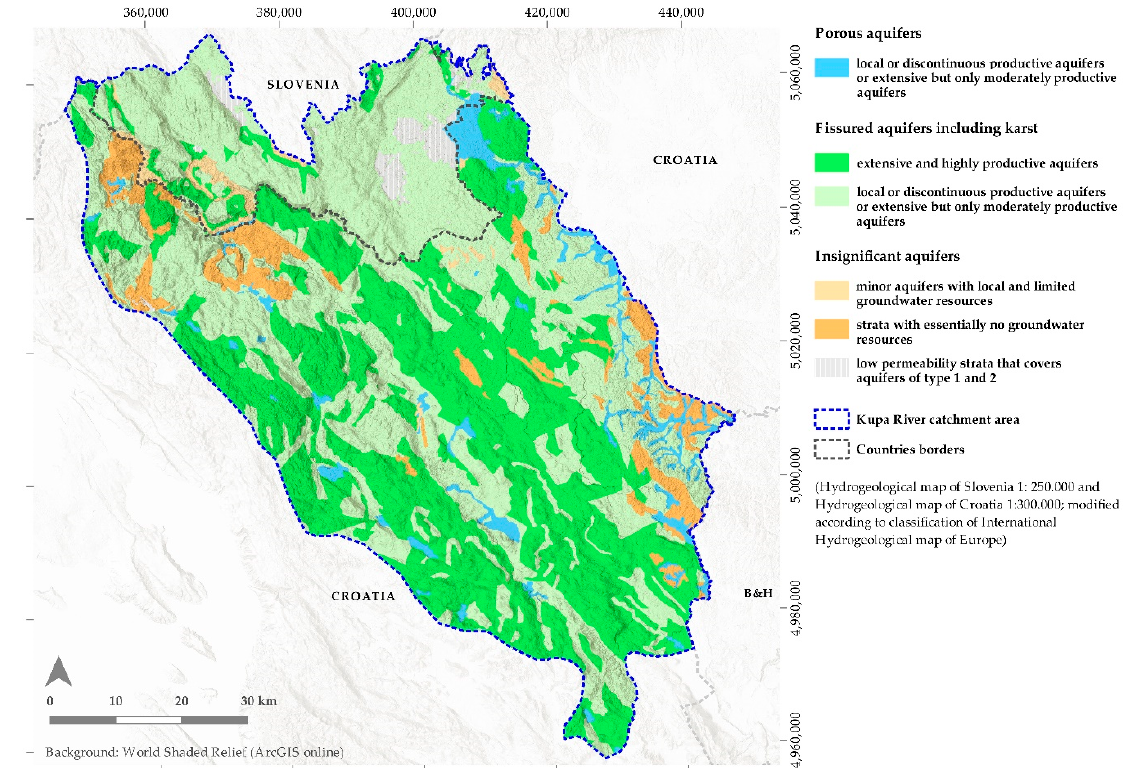
Figure 2. Hydrogeological map of the Kupa River catchment [39,40], according to the classes of the International Hydrogeological Map of Europe 1:1,500,000 [41].